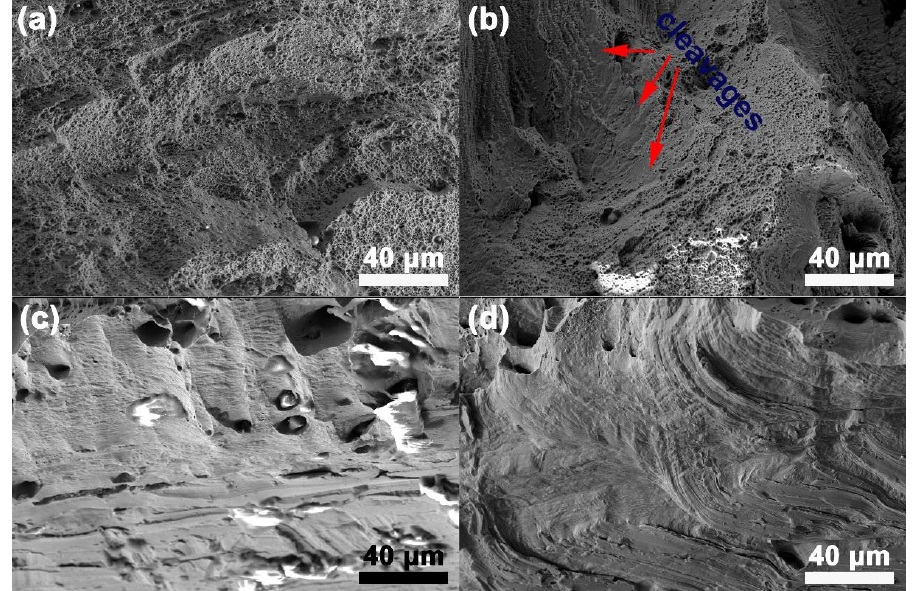
Figure 7. Fractographies of the base ( a ), W1 ( b ), W2 ( c ) and W3 ( d ).